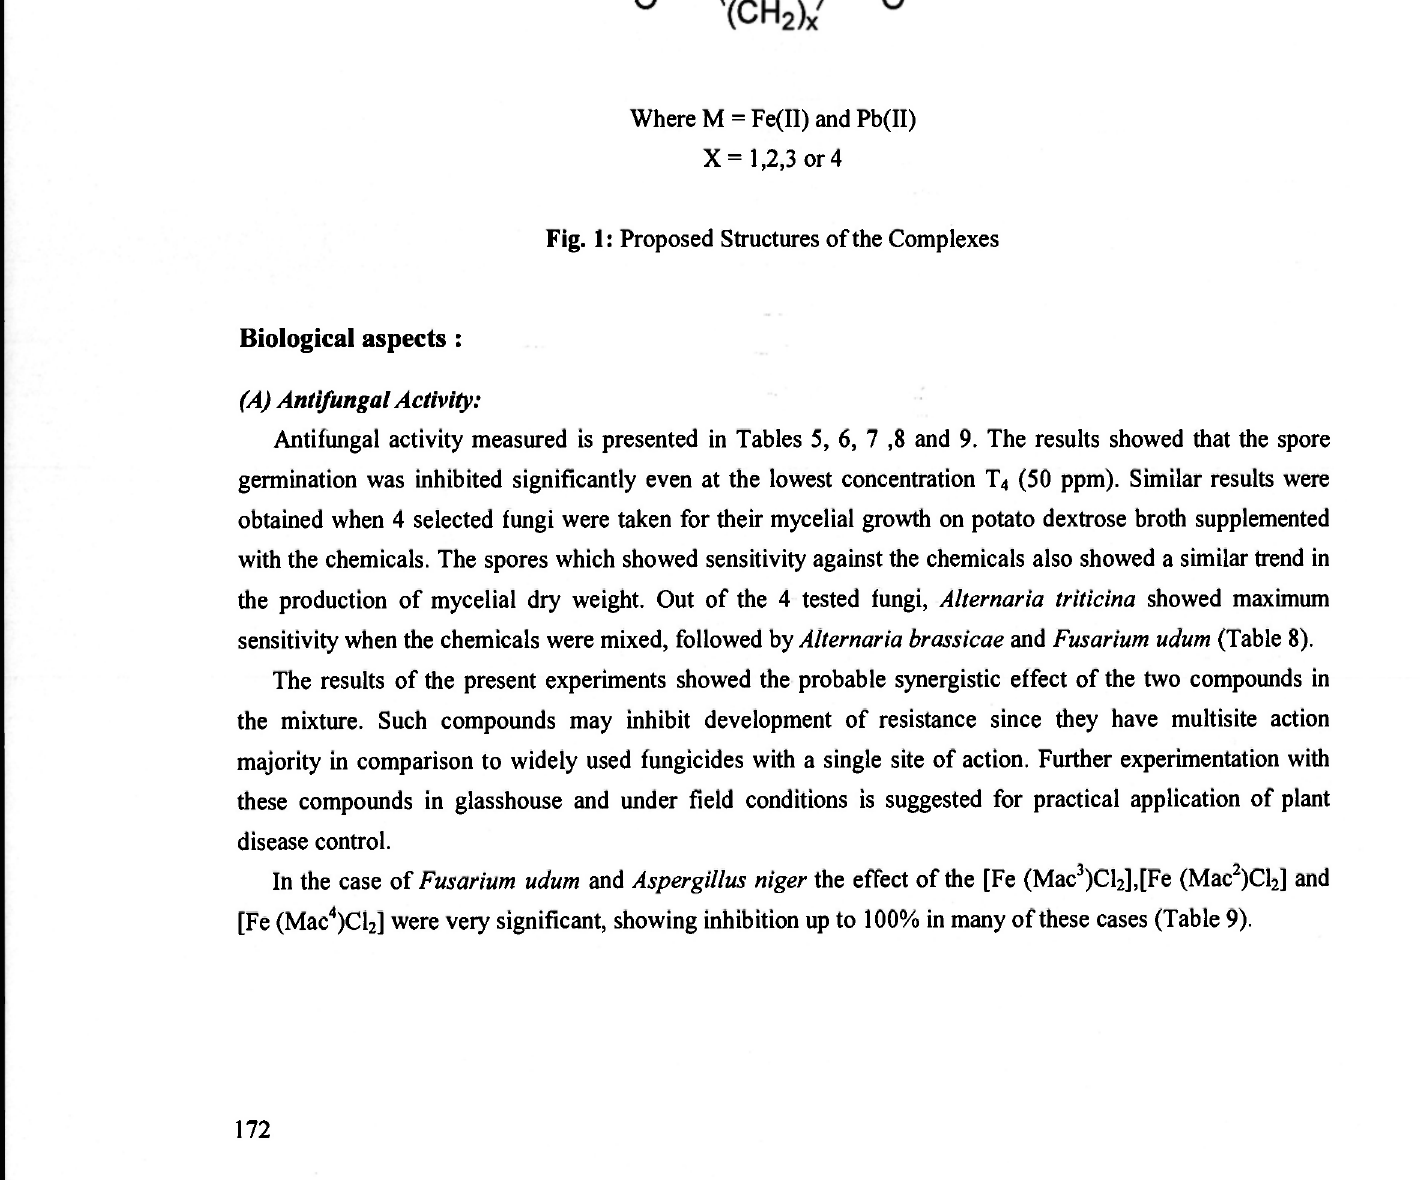
Fig. 1: Proposed Structures of the